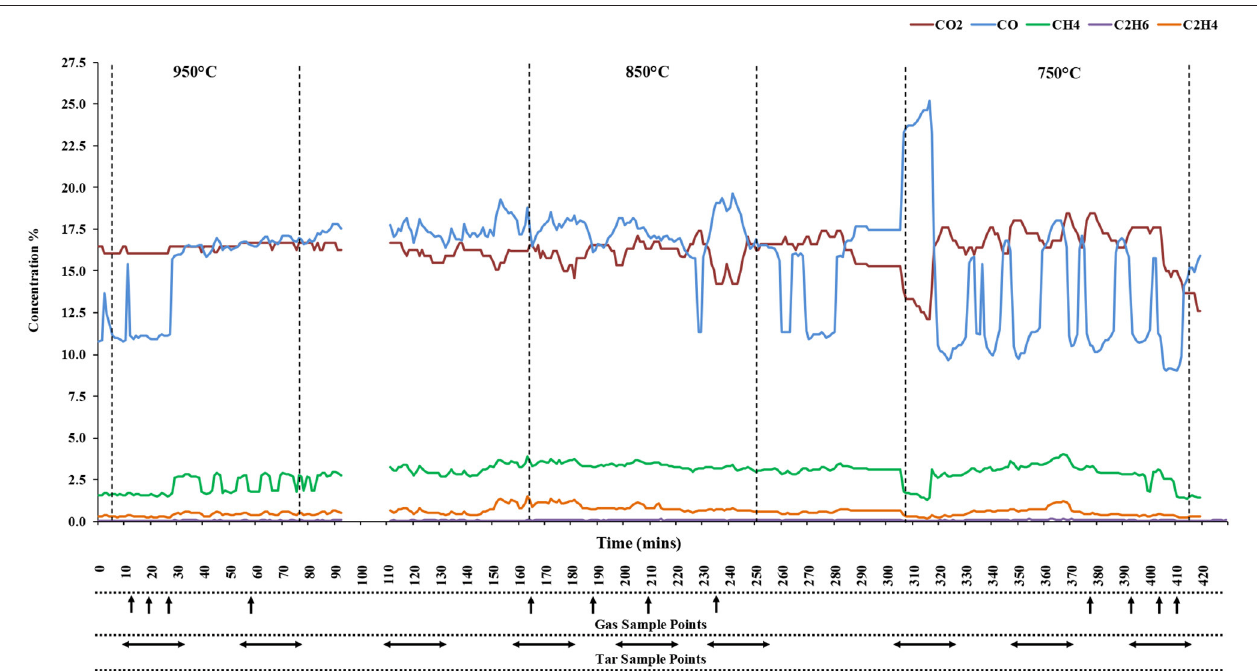
FIGURE 5 | Gas composition monitoring and gas, tar sampling times.